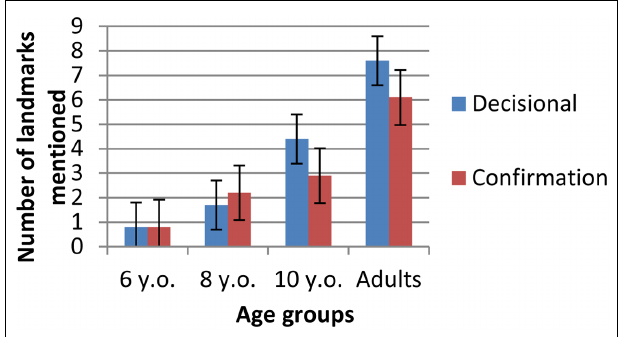
FIGURE 6 | Mean scores for decisional and confirmation